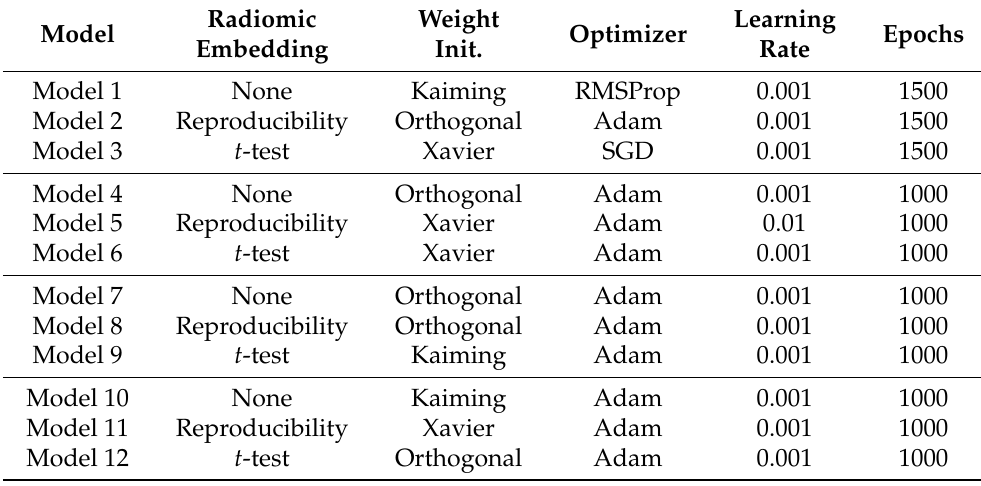
Table 7. Hyperparameters of best models.